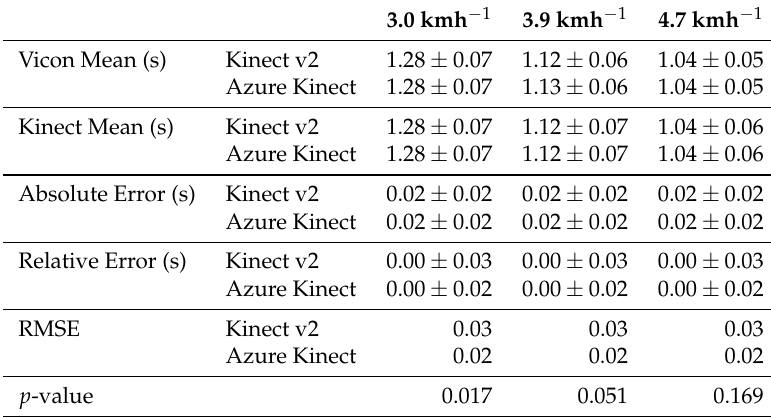
Table 7. Stride time gait parameter